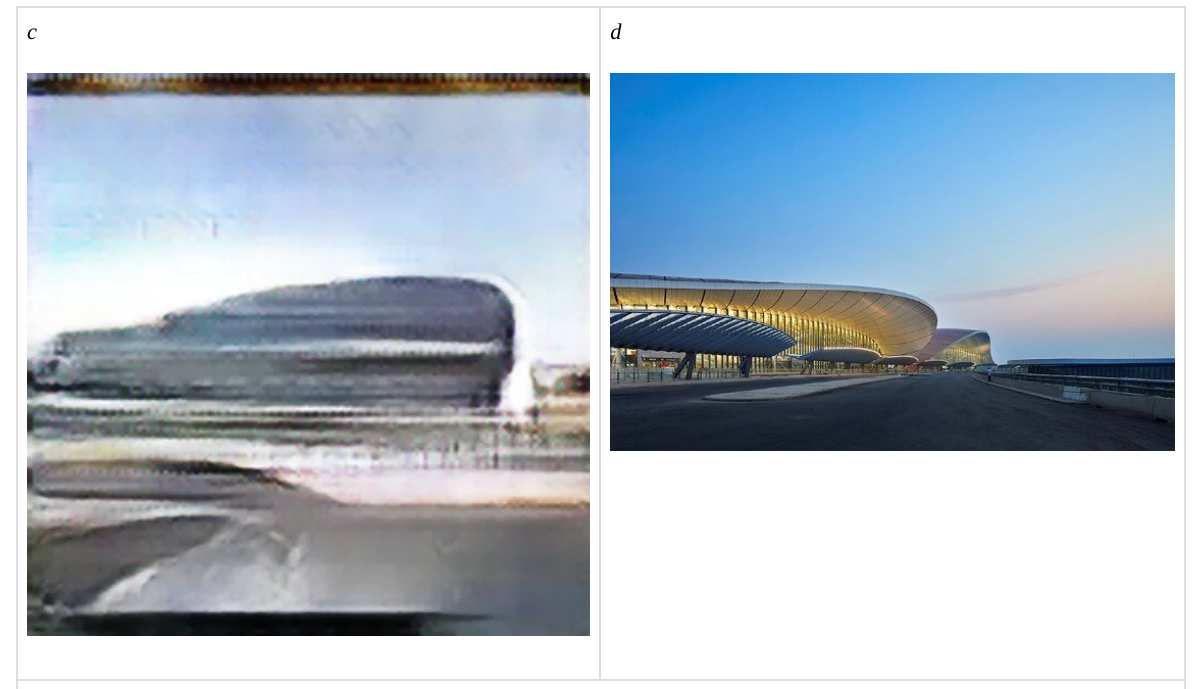
Figure 4. GAN Hadid. This illustrates the initial results at the epoch 1 (4a) and final ones at epoch 30 of the 1st stage (4b). Figure 4c and 4d show the original photograph of Hadid’s building (4d) and a new configuration generated by Wallish (4c). Figure 4c is generated by Wallish: From: https://www.seanwallish.com/gan-hadid. Figure 4d: Zaha Hadid Architects Beijing Daxing International Airport. https://www.zaha- hadid.com/architecture/beijing-new-airport-terminal-building/. Photograph: Hufton +